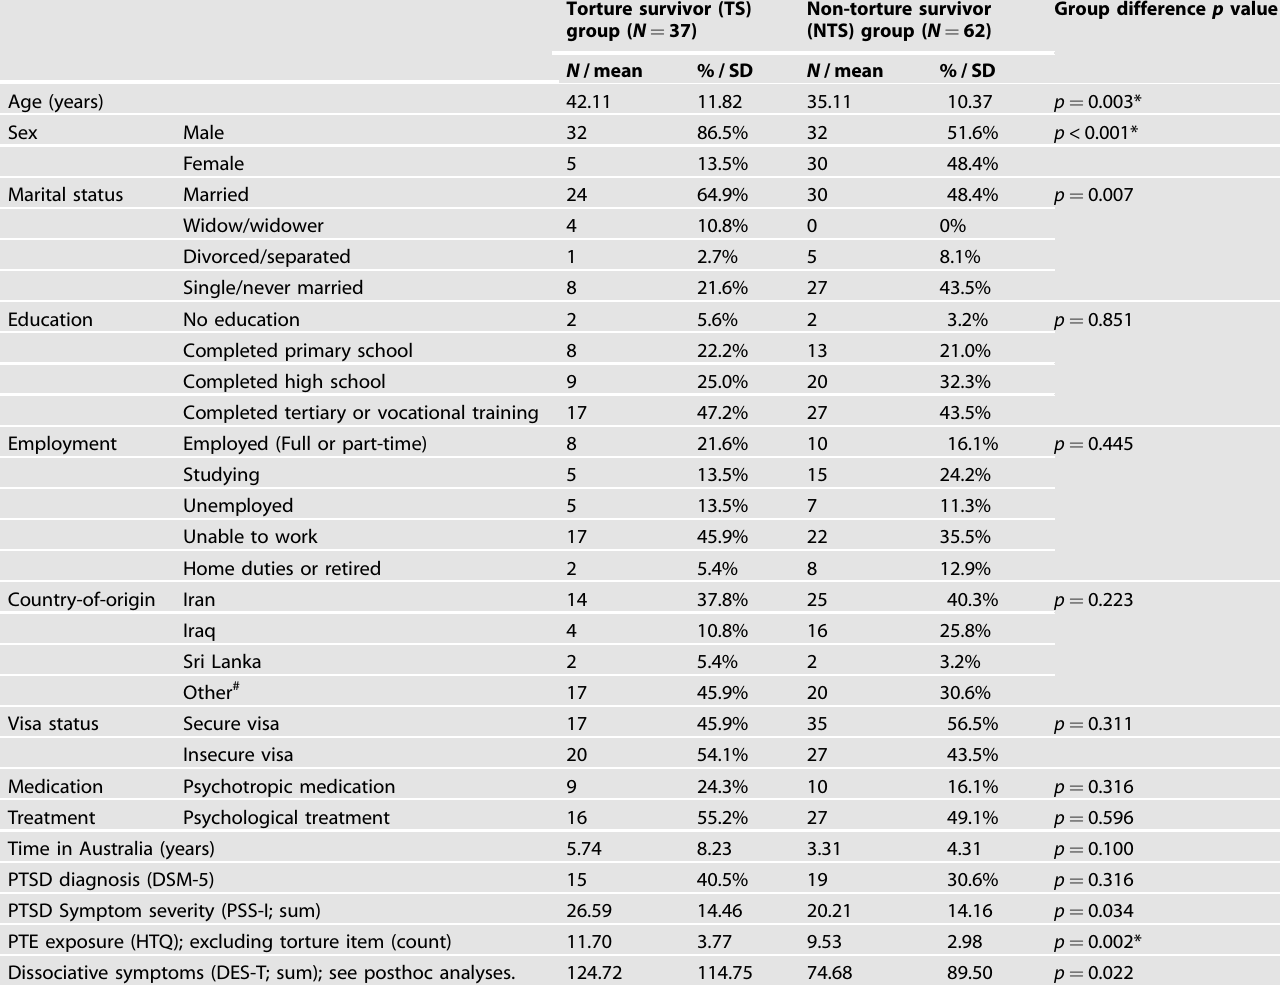
Table 1. Participant demographic and mental health